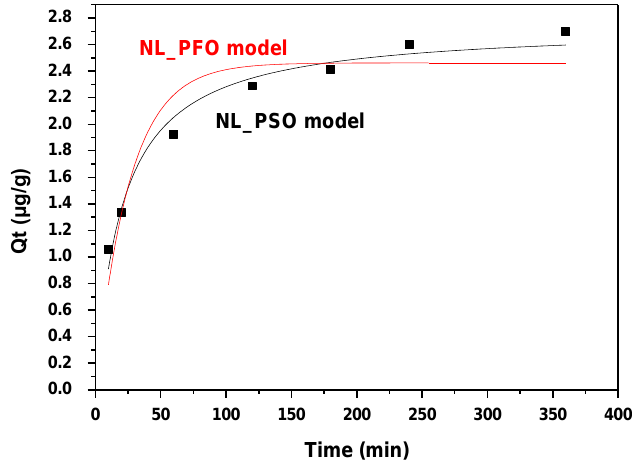
Figure 7. Kinetic models of pseudo-first and pseudo-second order for the adsorption of As(III) onto the combination of GO (0.2 g/L) and GFH (0.1 g/L); initial As(III) concentration 100 μg/L, pH 7.0 ± 0.1, T = 298 K, in deionized water.